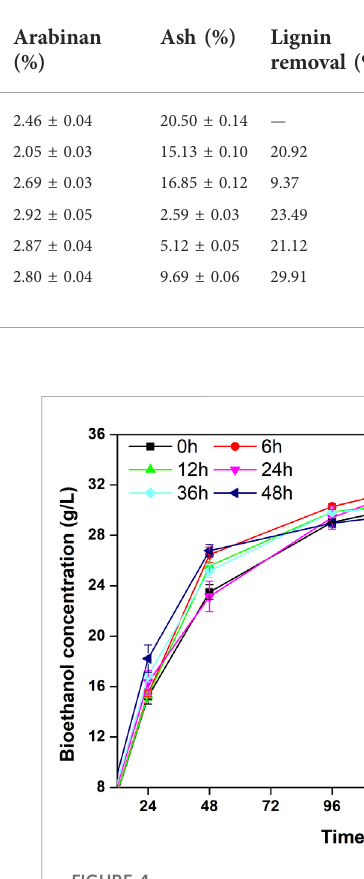
FIGURE 4 Time courses of ethanol production for different pre- enzymolysis